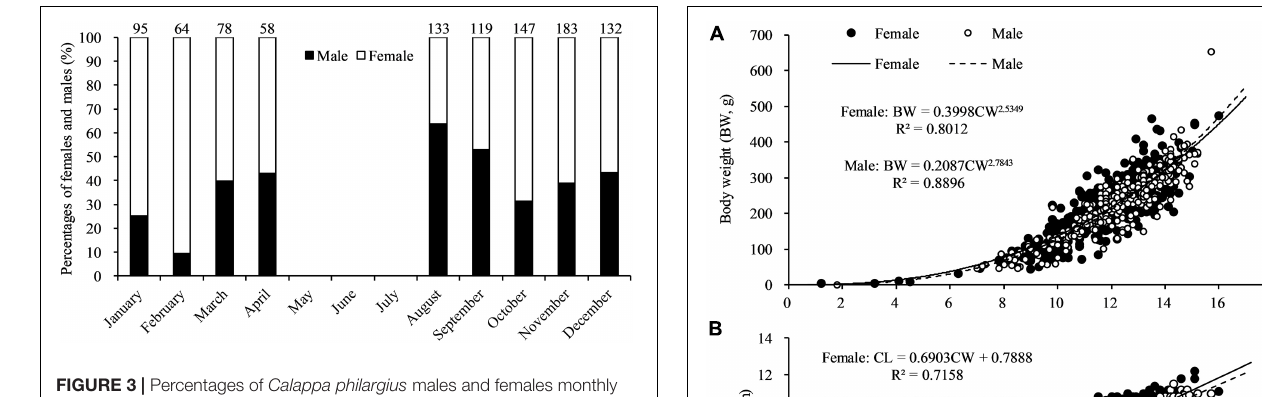
FIGURE 3 | Percentages of Calappa philargius males and females monthly from January to December 2019. No samples in May–July 2019. Numbers above the bars referred to sample sizes.